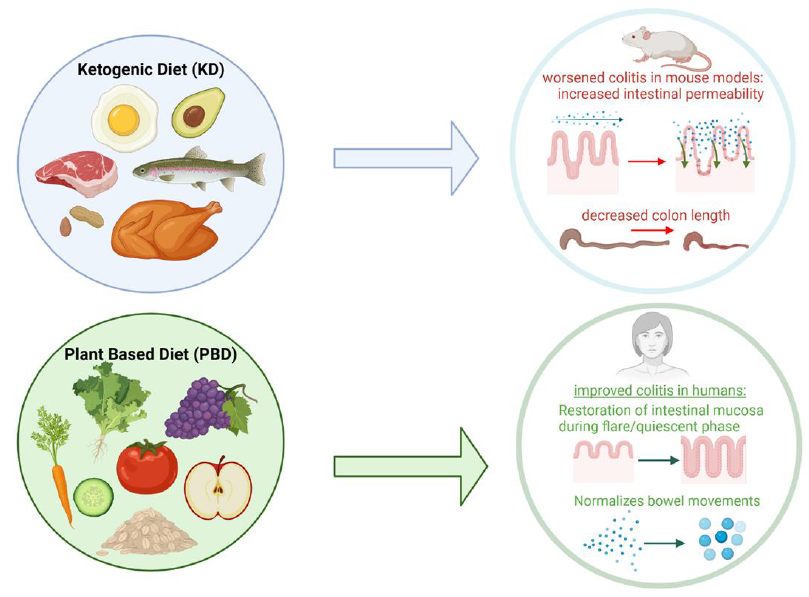
Figure 4. Specific Dietary Interventions in IBD: Ketogenic Diet (KD) and Plant-Based Diet (PBD) in in IBD.